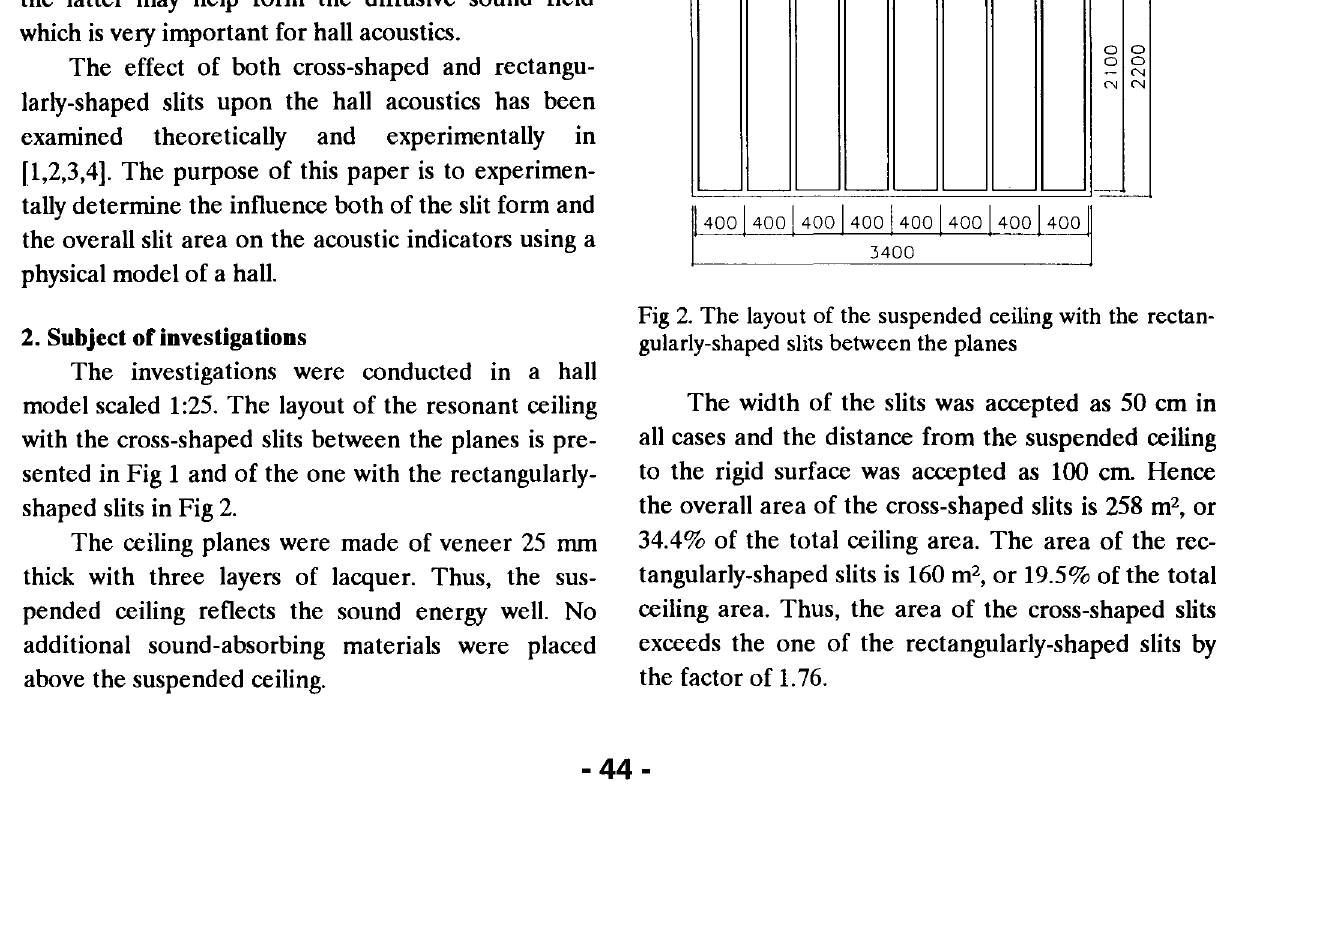
Fig 1. The layout of the suspended ceiling with the cross shaped slits between the planes